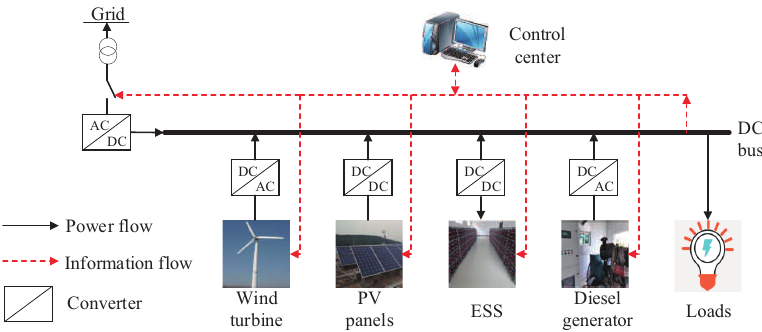
Figure 2. The schematic diagram of microgrid